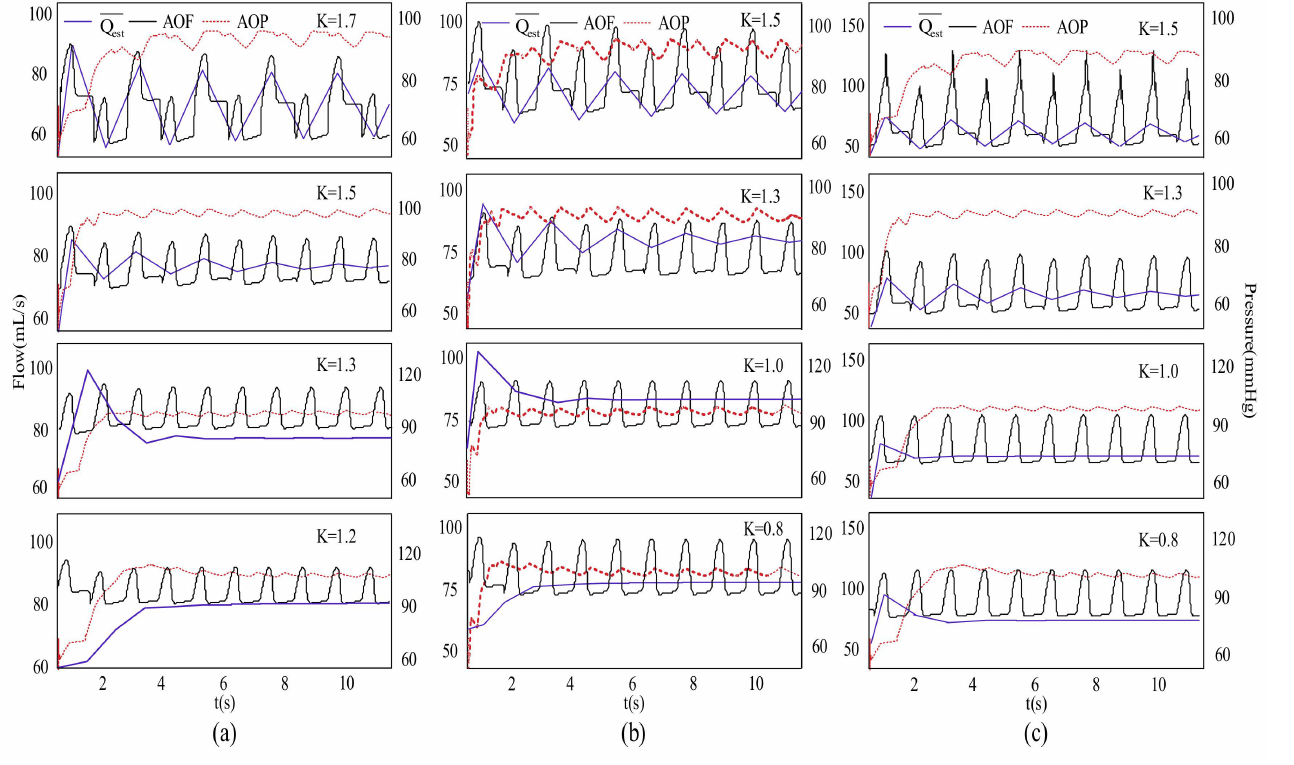
Figure 5. Changes in hemodynamic parameters as K values change for different degrees of heart failure. ( a ) Emax = 0.5, severe HF. ( b ) Emax = 1.0, moderate HF. ( c ) Emax = 1.5, mild HF. K: